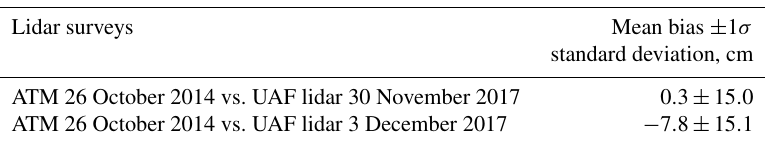
Figure 5. Along-track elevation and elevation differences associated with GPS B. (a) Along-track elevation of GPS B, in meters. (b) Elevation difference between GPS B and the UAF lidar (30 November 2017), minus the mean difference. (c) Elevation difference between GPS B and the UAF lidar (3 December 2017), minus the mean difference. (d) Elevation difference between GPS B and ATM (26 October 2014), minus the mean difference. Table 2. Elevation bias and surface measurement precision (cm), between ATM and the UAF lidar. Results are posted as ATM elevation – UAF elevation